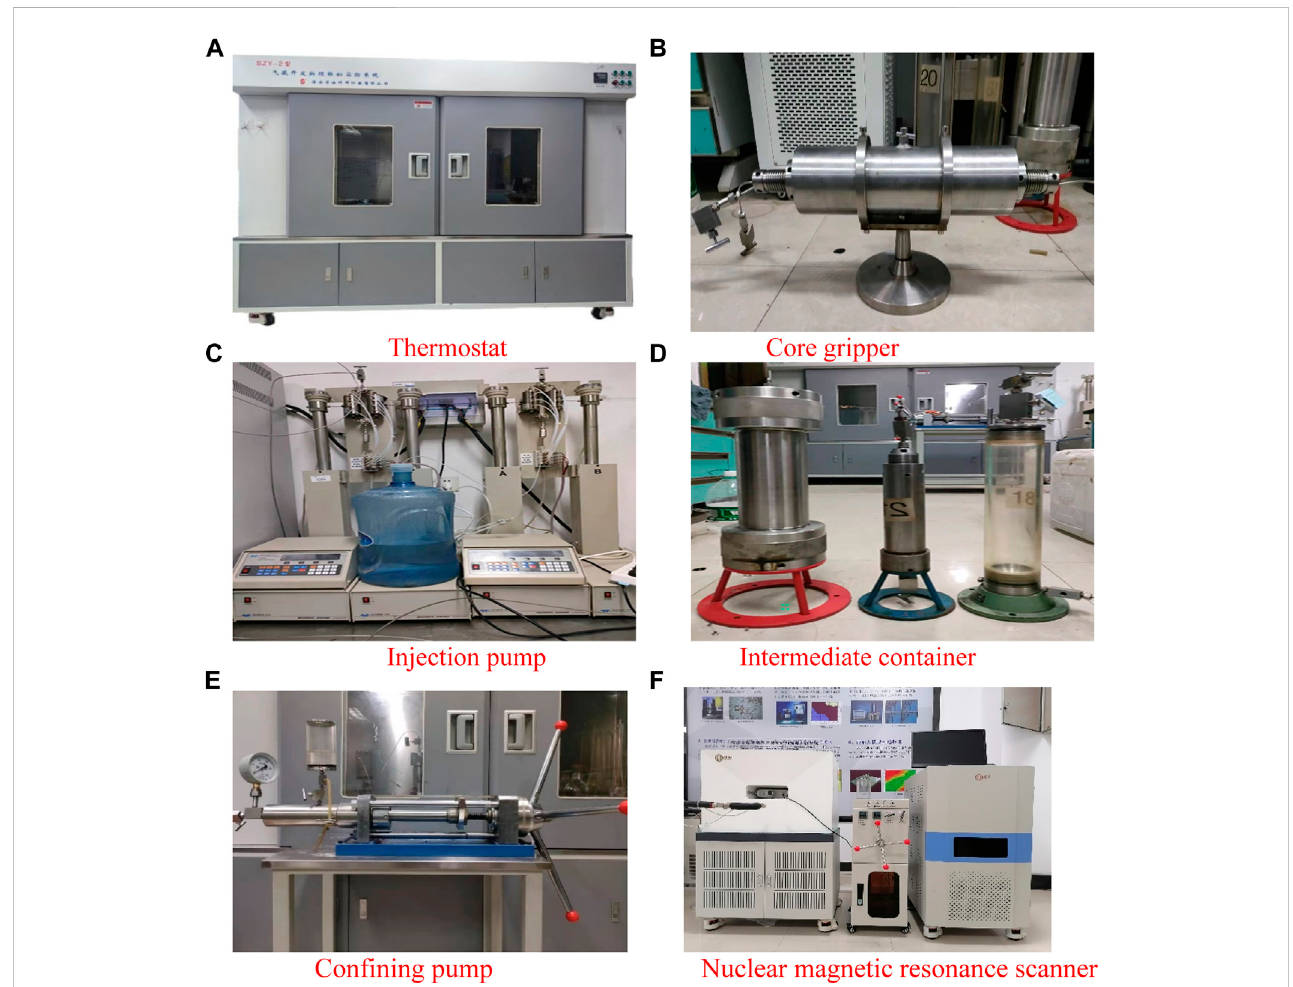
FIGURE 3 Experimental apparatus, (A) thermostat, (B) core gripper, (C) injection pump (D) intermediate container, (E) con fi ning pump, and (F) nuclear magnetic resonance